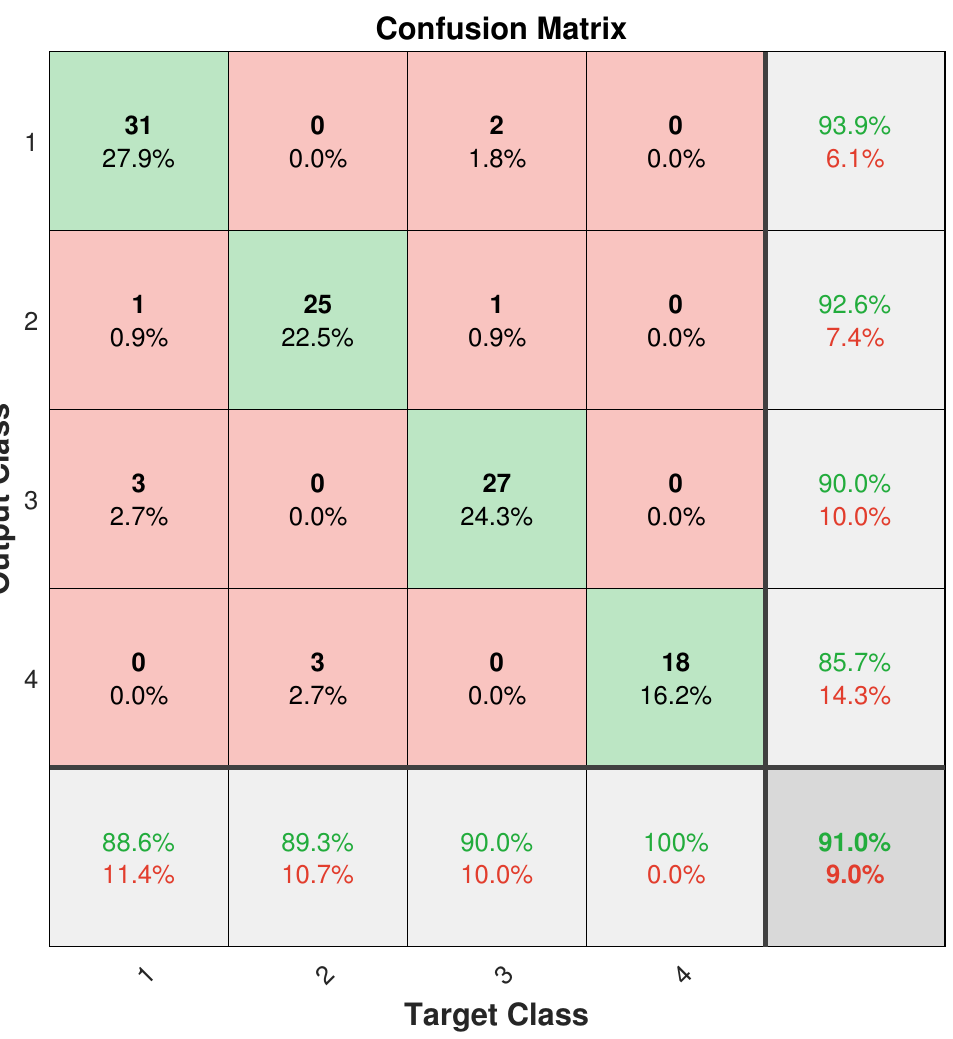
Figure 11. Test confusion